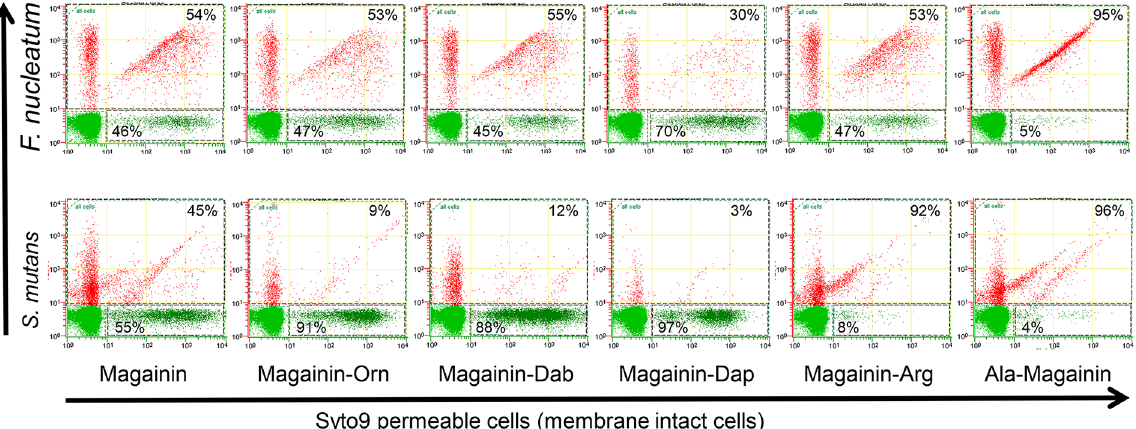
Fig 2. Flow cytometry dot plots of F . nucleatum and S . mutans incubated with magainin analogues at a concentration equivalent to the MIC50 concentration of magainin. Cells stained with Syto9 dye (membrane permeable) and propidium iodide dye (membrane impermeable).